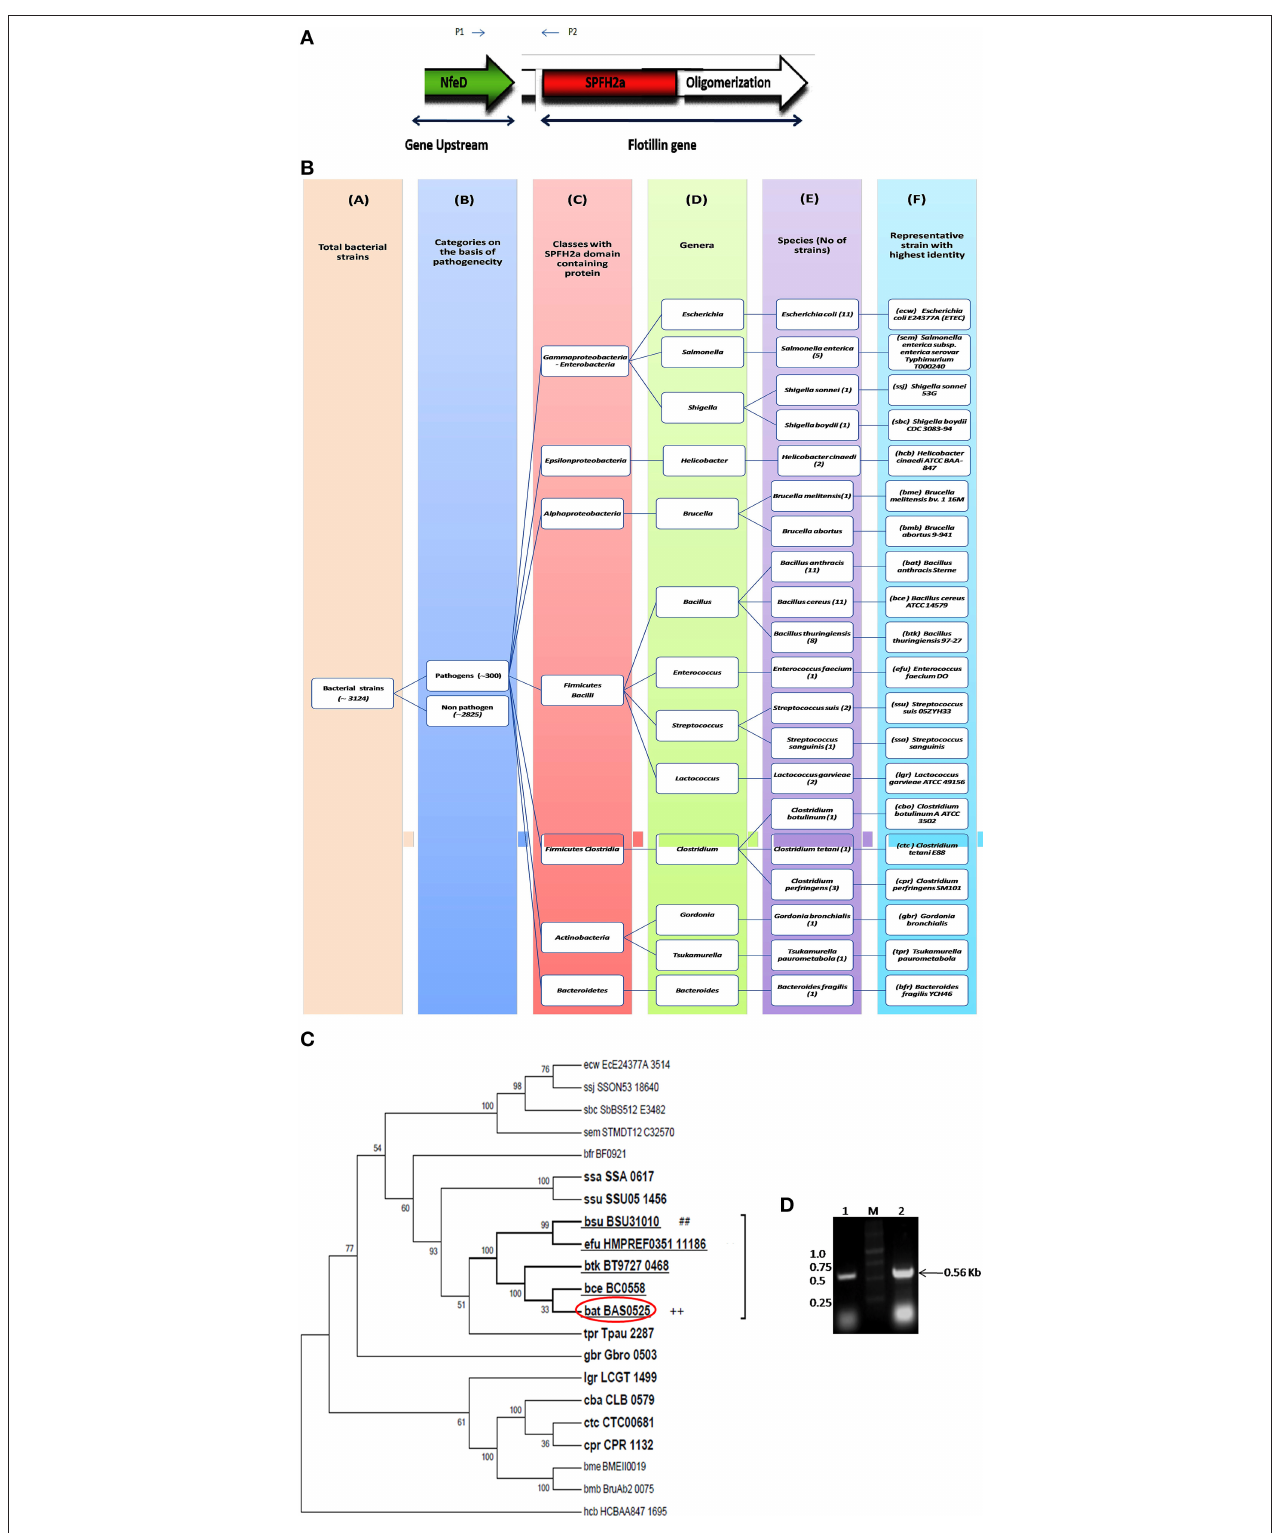
FIGURE 1 | Flotillin-associated domains and identification of flotillin homologs in pathogens. (A) Representation of various domains associated with Raft Marker Protein or Flotillin-1. (B) Schematic representation of 20 shortlisted bacterial pathogens containing proteins of SPFH2a superfamily, each representing individual species. Columns: C, Classes; D, Genera; E, Species; F, Selected strain showing maximum identity with SPFH2a domain. Number in bracket in column E